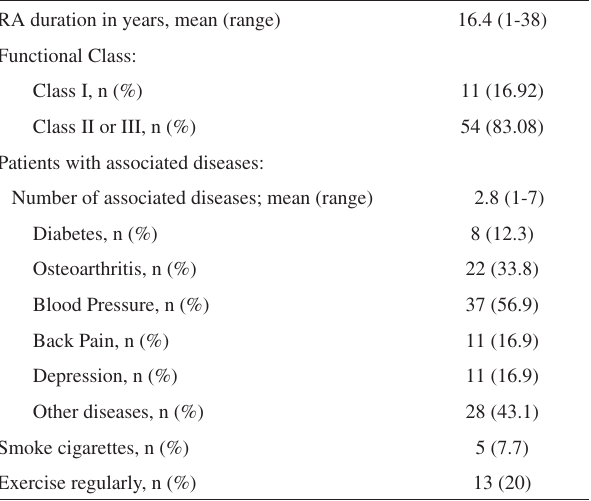
Table 2 - Clinical data characterizing the disease and associ- ated diseases of the study group (n = 65)